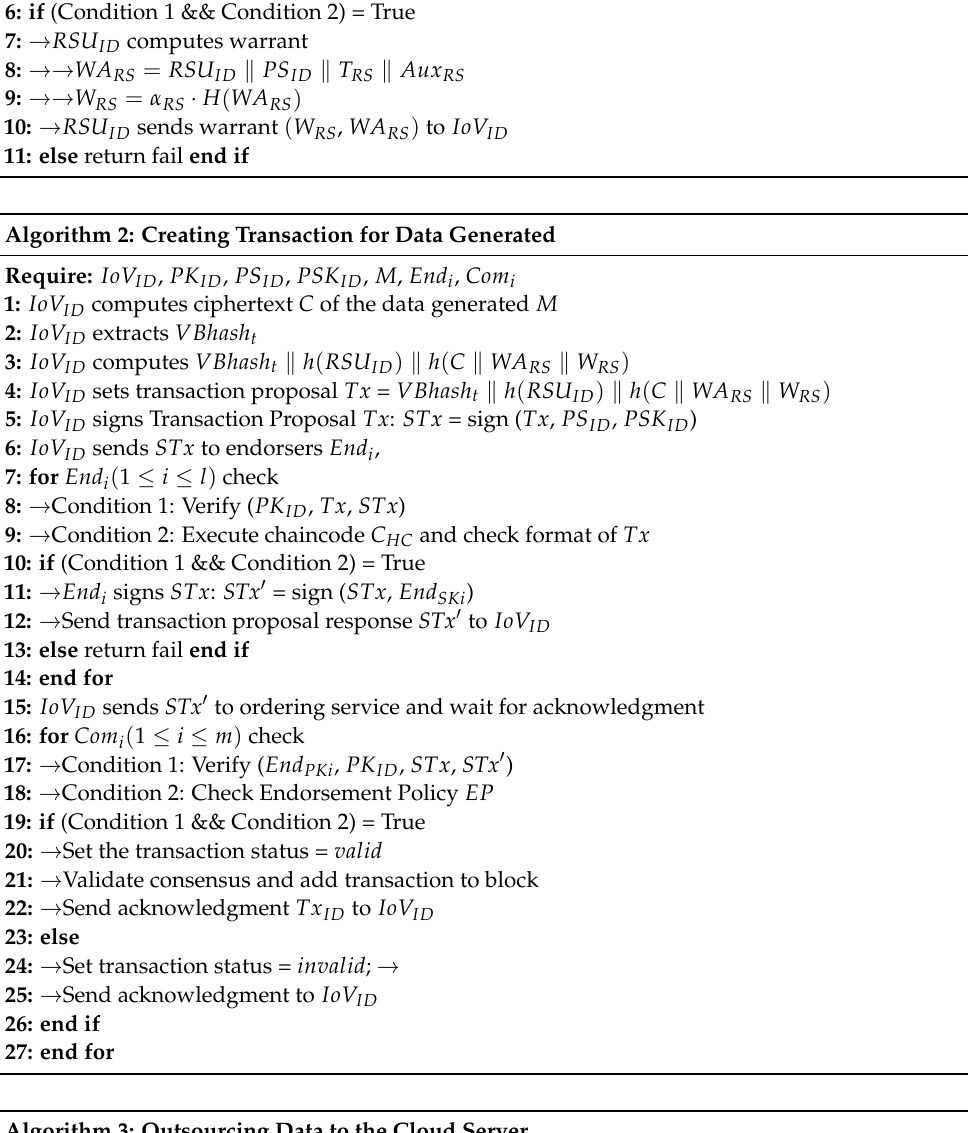
Algorithm 1 Requesting for Warrant from RSU node